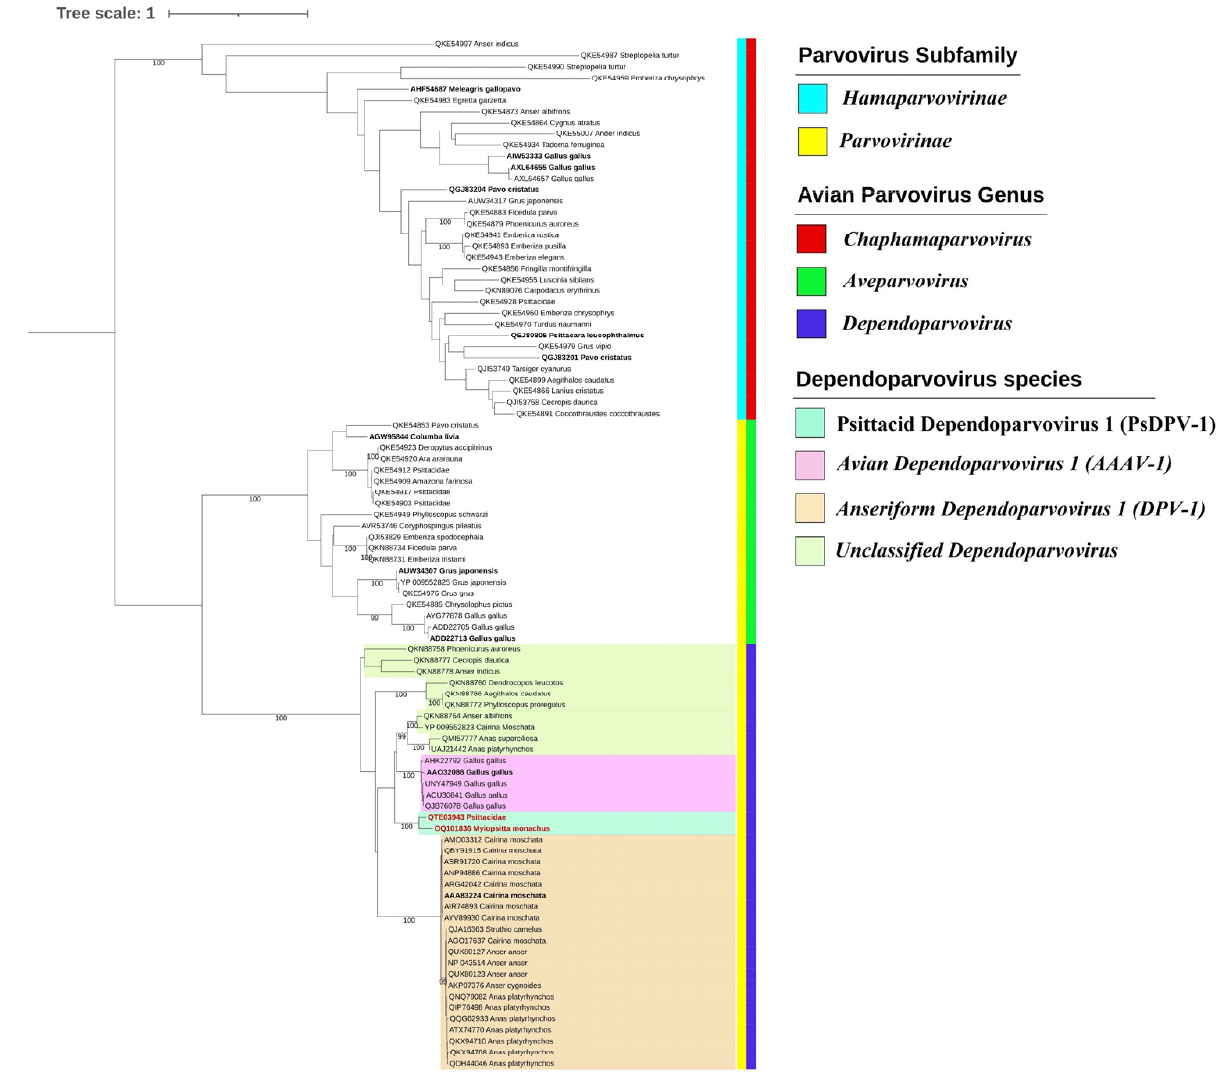
Figure 3. Maximum-likelihood phylogenetic inference of 92 Rep protein sequences of avian parvoviruses. The tree was inferred under a Q.pfam+R+F amino acid substitution model with nodal support values based on 1000 bootstrap replicates. The color code for the subfamilies, genera, and species used in the vertical bars to the right of the names of the species in the tree is indicated in the legend on the right. Representative sequences of avian parvovirus species are highlighted in bold, and the dependoparvoviruses from Psittacidae are highlighted in red. Only the support values above 98 are displayed. 4. Discussion The population of exotic invasive species such as monk parakeets has increased in several European cities and most urban areas along the Mediterranean coast. Madrid is the area with the highest concentration of monk parakeets in Spain [7]. They constitute a severe threat to native bird species, habitats, or ecosystems, and therefore the study of their virus is of particular interest. In this study, we have detected and characterized in cloacal samples from urban pop- ulations of M. monachus a novel genome of dependoparvovirus, named Sp_PsDPV. The virus has a classic parvovirus structure, and its genomic organization and phylogenetic inference place it in the Dependoparvovirus genus. The genomic organization is similar to that of the closest dependoparvovirus relative, also identi fi ed in the feces of a Chinese wild psi tt acid (Ch_PsDPV) [34], although it is a partial sequence that has not allowed a complete comparison of the genome. In both viruses, three promoters have been identi fi ed in positions similar to those described in the genus, although the fi rst promoter of Sp_PsDPV (comparable to P 5 ) lacks a canonical TATA-box. The analysis of this region shows that it might belong to a CpG island-associated category of promoters, most of them related to RNA polymerase II [38]. However, no CpG islands were founded in Ch_PsDPV.